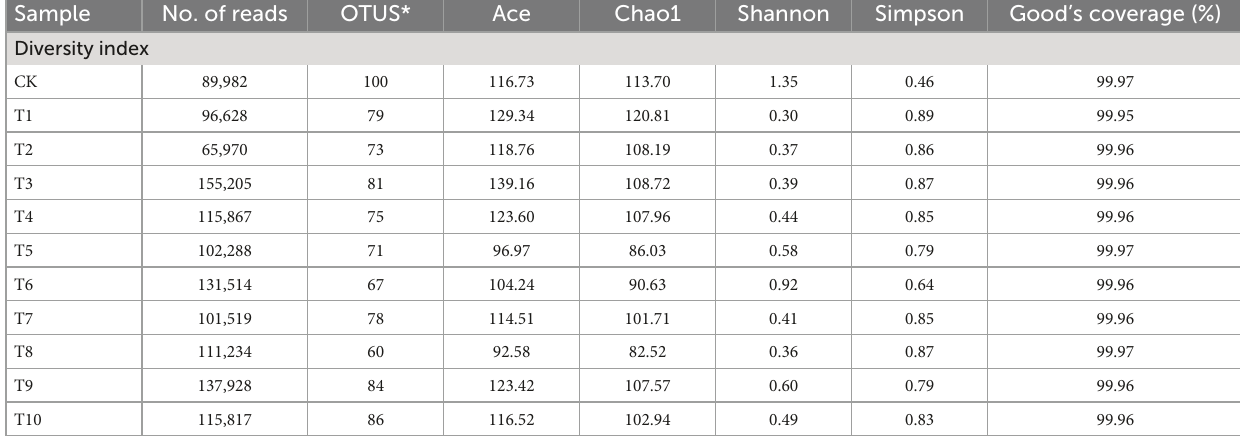
TABLE 1 Sequencing analysis of 16S rRNA gene amplicons of A. gossypii with diversity indices.